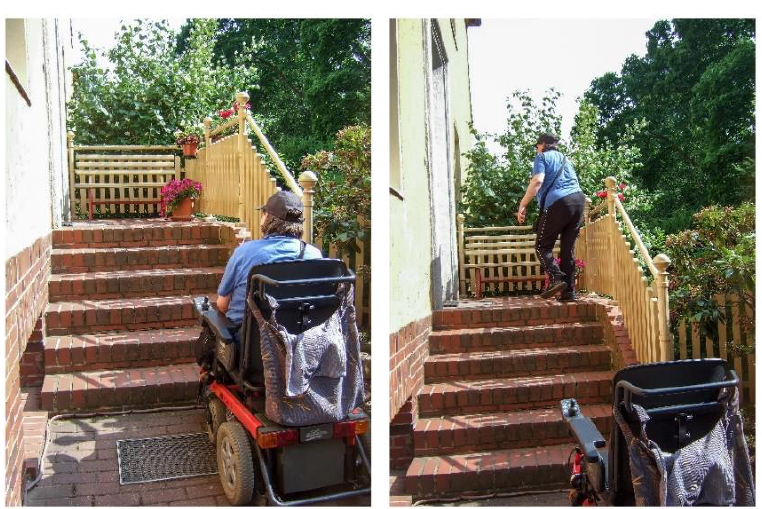
Figure 3. Bus stop.